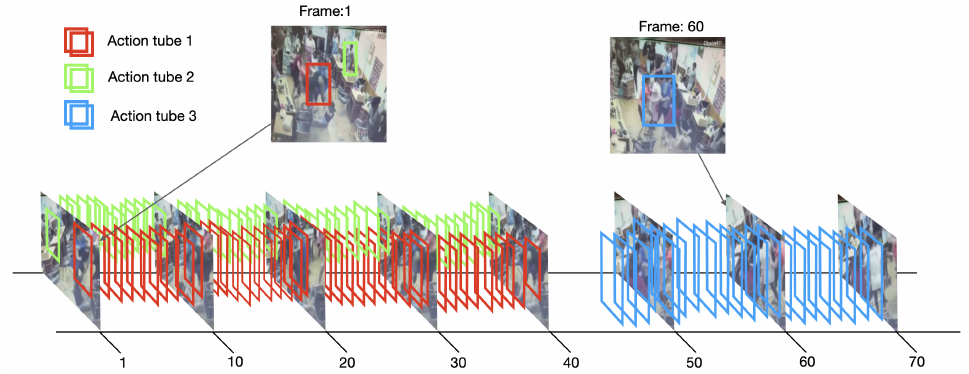
Figure 5. Online tube generation in a violent video from RWF-2000 dataset [17]. The detection boxes are incrementally linked to built space–time action tubes. Note that each tube could have a different temporal length, e.g., Action tube 1 has a length of 40 frames (from frame 1 to frame 40), and Action tube 3 has a length of 25 frames (from frame 45 to frame